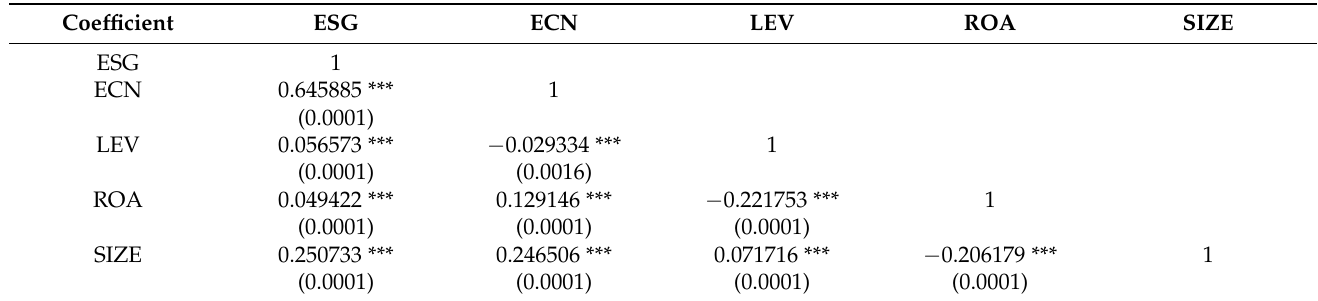
Table 4. Spearman correlations matrix.